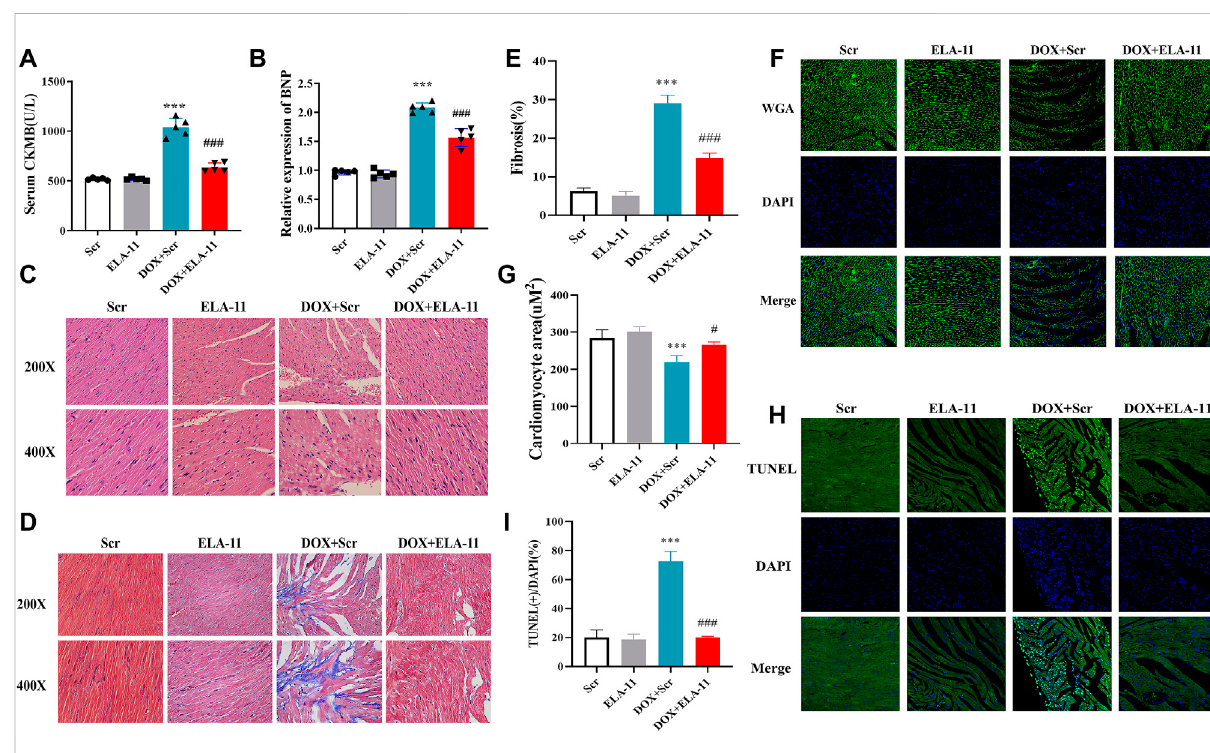
ELA-11 protects doxorubicin-injured heart in vivo. (A) Serum CKMB release in DOX-injured model. (B) Serum BNP release in DOX-injured model. (C) RepresentativephotographsofHEstaining. (D) RepresentativephotographsofMassonstaining. (E,F) RepresentativephotographsofWGA staining and its quantitative data. (G,H) Representative photographs of TUNEL staining and its quantitative data. *** p < 0.001 and ### p < 0.001, one- way ANOVA, N = 5 mice per